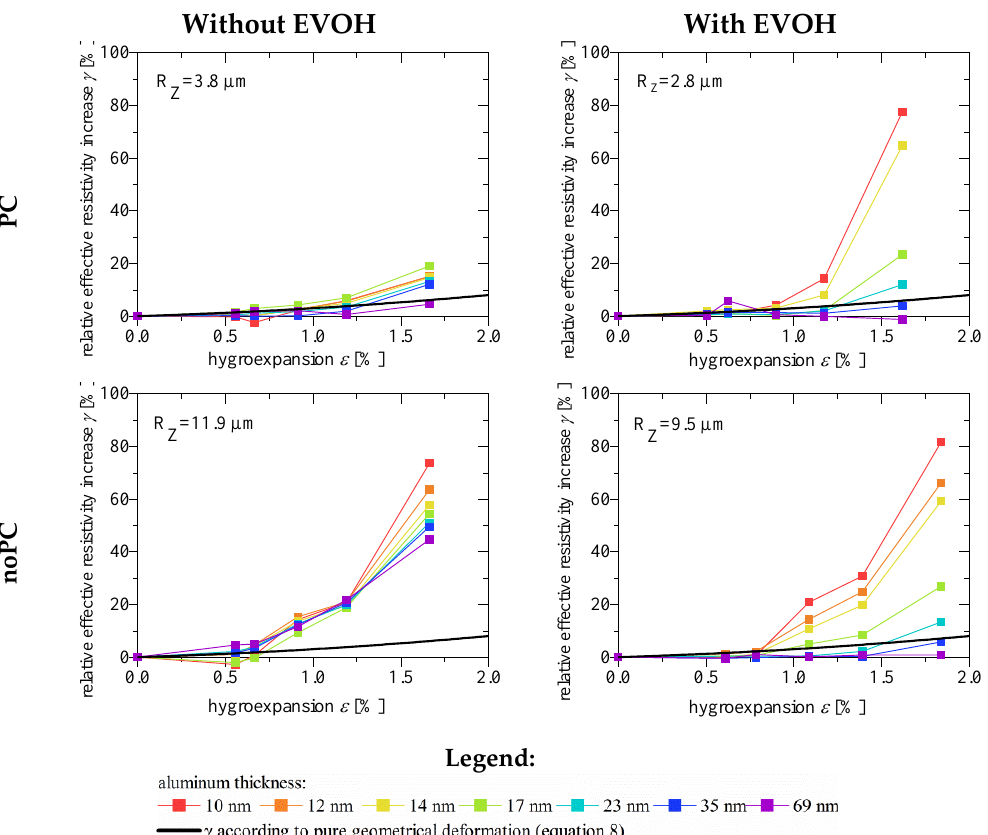
Figure 6. Increasing roughness R Z and porosity of the substrate paper Metalkote increased the effective resistivity ρ EFF due to defects in the aluminum coating. Although the EVOH coating only had a minor impact on roughness values R Z , the resistivity was lower due to the lower porosity. PC/noPC = paper surface with/without pigment coating. EVOH = ethylene vinyl alcohol lacquer.